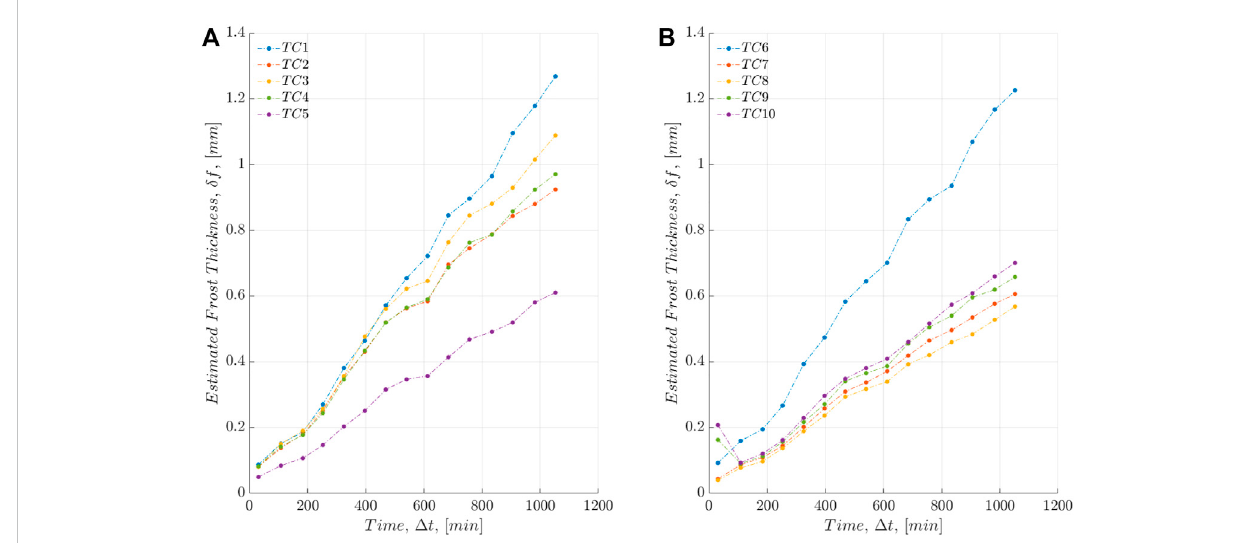
FIGURE 8 Estimated frost thickness. (A) HX outer facing row; (B) HX inner facing